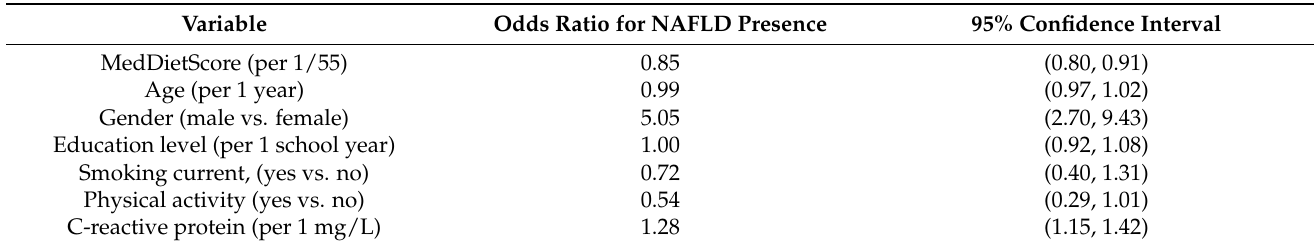
Table 2. Cross-sectional multivariable logistic regression model for the association between NAFLD presence and Mediterranean-type diet ( n = 477) 1